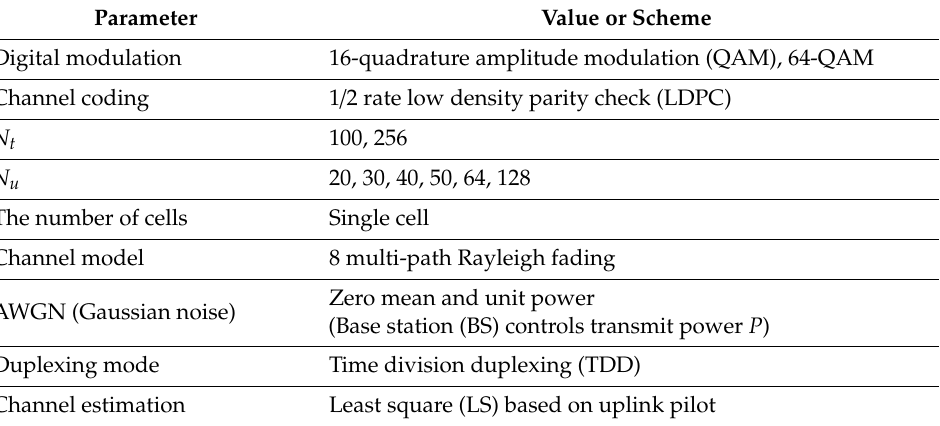
Table 3. The simulation parameters